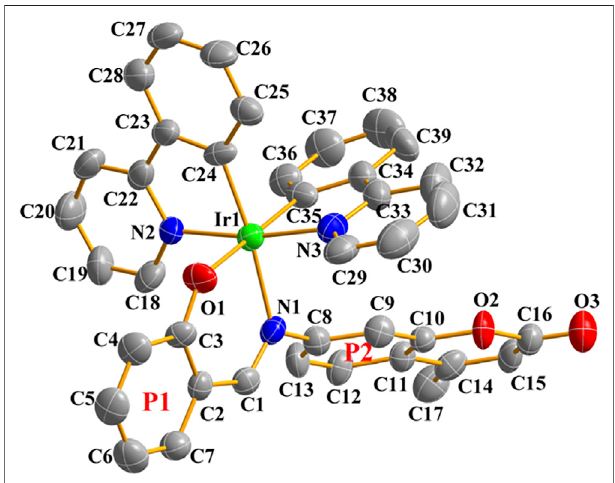
FIGURE2| Single-crystalORTEPdiagramofIr1(50%thermalellipsoids, hydrogen atoms were omitted for clarity). CCDC number 2158102.